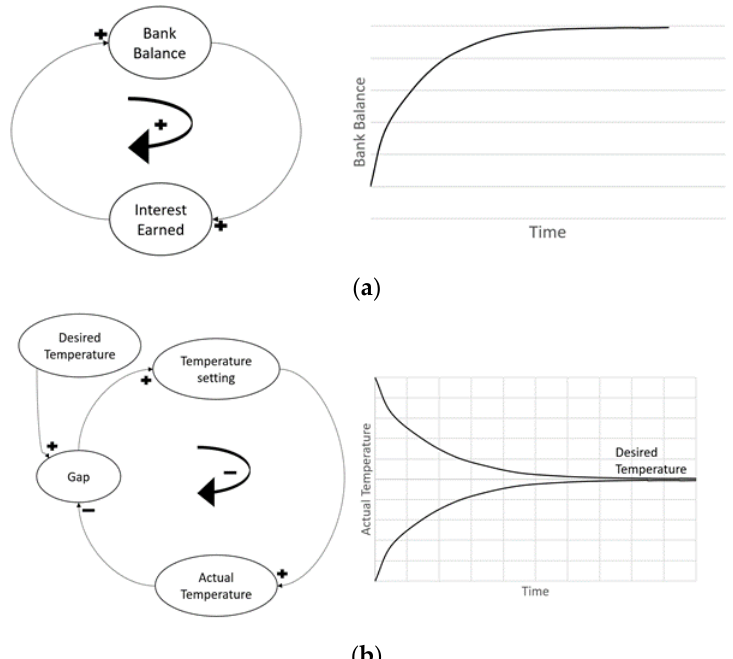
Figure 2. ( a ) Open Loop System; ( b ) Closed Loop System.